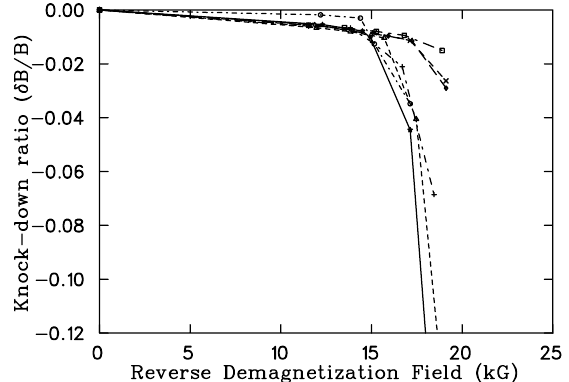
FIG. 2. Knock-down ratio vs the applied external reversal field for several magnet